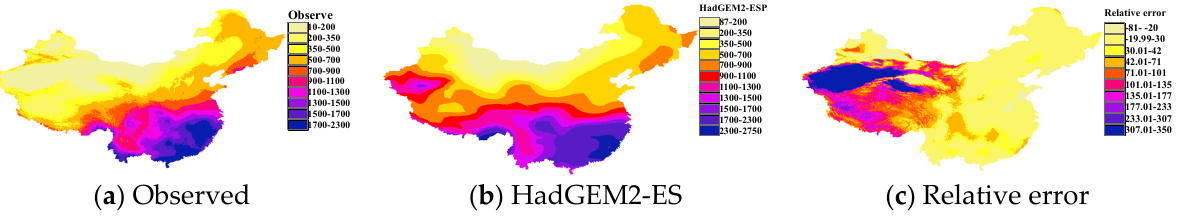
Figure 6. Spatial distribution of annual average precipitation (mm) at each grid point.